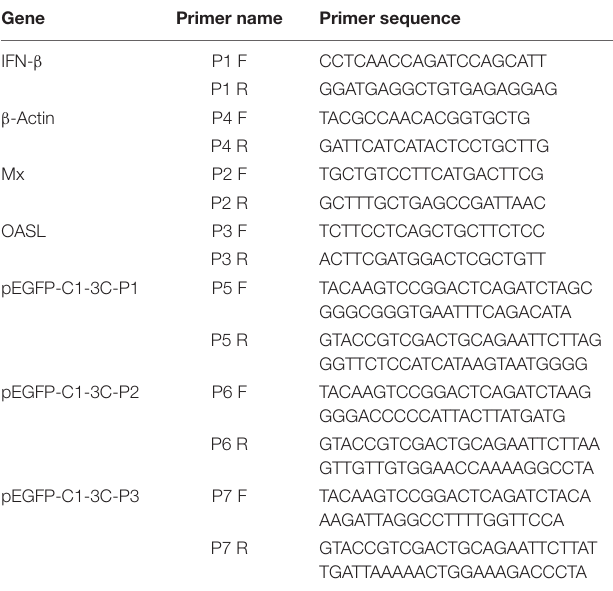
TABLE 1 | The sequences of all primers used in this